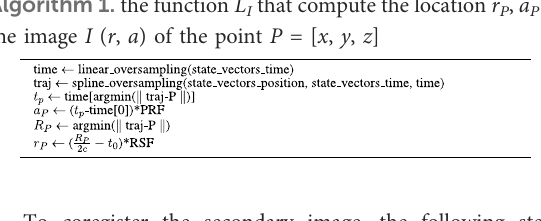
Algorithm 1. the function L I that compute the location r P , a P in